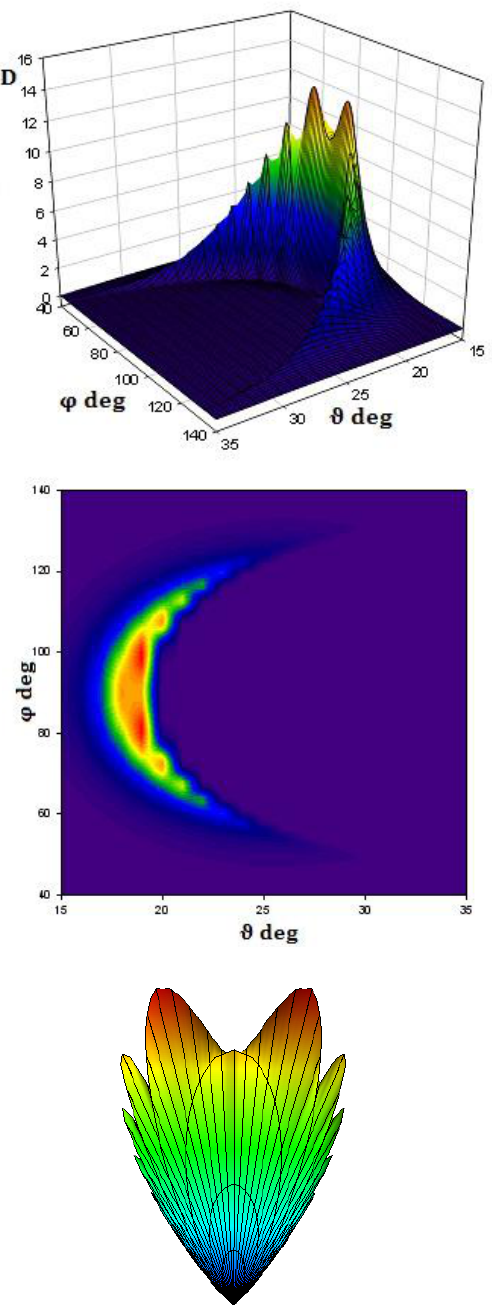
Figure 7b: The pattern of transmitted field f =37,2